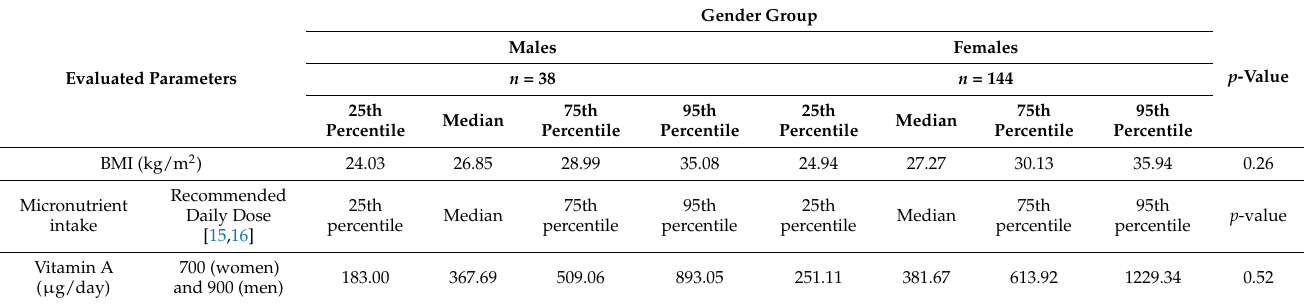
Table 2. Influence of the gender on the BMI, micronutrient intake and serum micronutrient s levels of elderly from Metropolitan Region, Santiago,